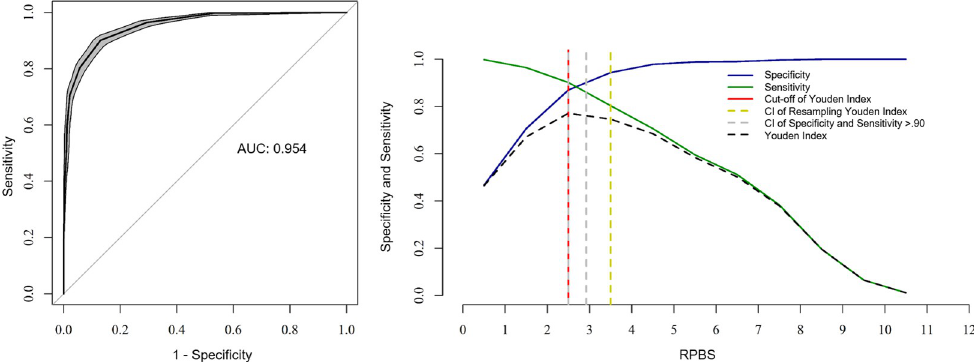
Fig 5. ROC curve and AUC [left] and ROC curve of two graphs with the diagnostic uncertainty zone for the RPBS [right]. ROC curve (receiver operating characteristic) with a 95% confidence interval (CI) calculated from 1,001 replications and area under the curve (AUC) [left]. Interpretation of AUC � 0.95—high discriminatory capacity. ROC curve of two graphs, CI of 1,001 replications and sensitivity and specificity > 0.90 applied to estimate the diagnostic uncertainty zone of the cut-off point, according to the Youden index for the Rabbit pain behaviour scale (RPBS) [right] [54, 55]. The diagnostic uncertainty zone scores ranged from 2.5 (3) to 3.5 (4); therefore, < 3 indicates truly negative pain (rabbit without pain) and � 4 indicates truly positive pain (rabbit suffering pain). A Youden index � 3 represents the cut- off point for indication of rescue analgesia